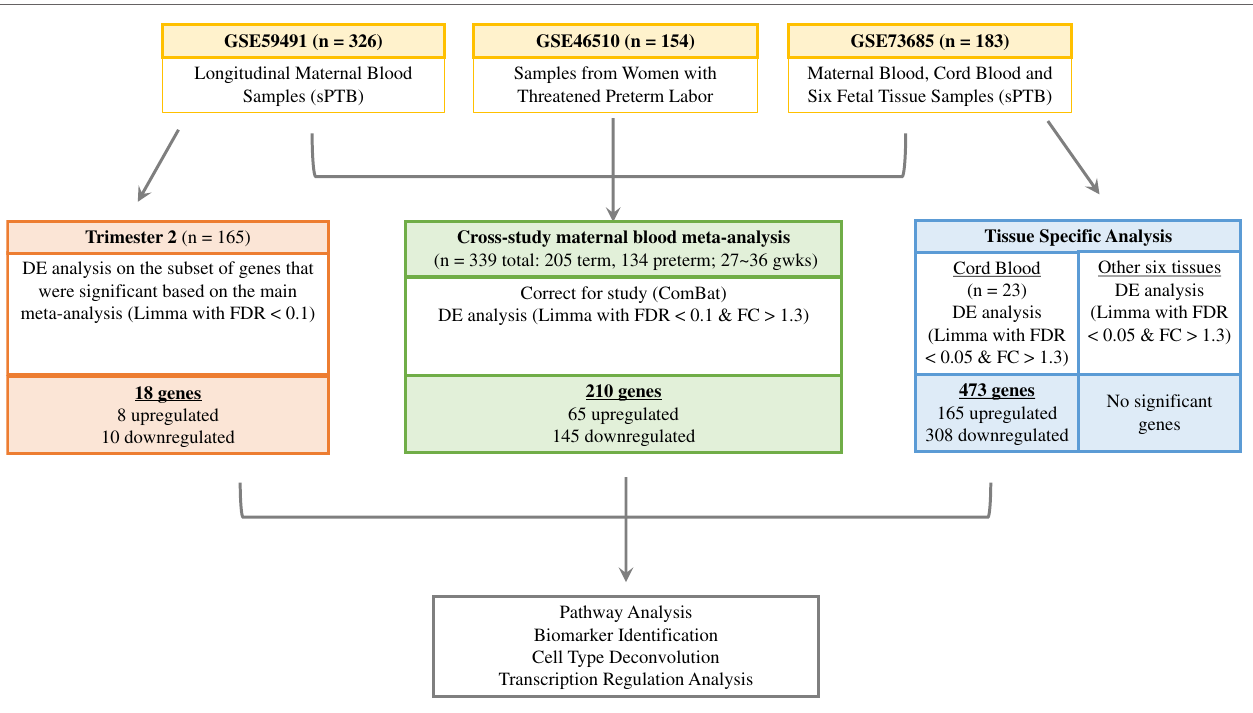
FiGURe 1 | Analysis of relationship of gene expression differences in term vs. preterm birth. We identified three independent studies from the Gene Expression Omnibus database (in yellow) to perform a meta-analysis using third trimester maternal blood samples (in green), an additional differential expression analysis with second trimester samples from GSE59491 (in orange), and a tissue-specific analysis with samples from GSE73685 (in